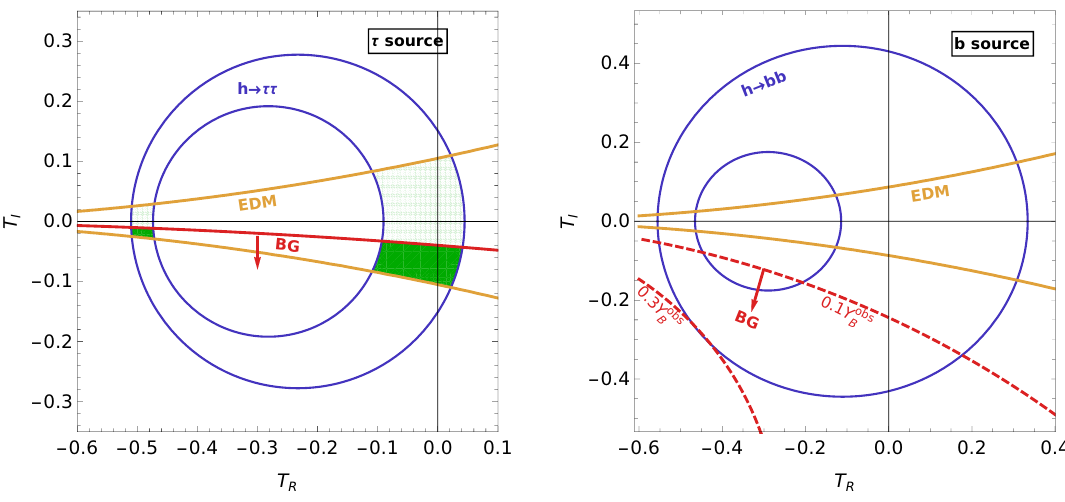
Figure 1 . Constraints on ( T f ; T f ), f = (cid:28); b , from (cid:22) (blue), d e (yellow) and Y B (red). Solid lines f (cid:22) f R I represent bounds, dashed red lines represent iso- Y B curves within the bound. Regions allowed by all constraints are highlighted in green. Left: (cid:28) -lepton source, right: b -quark